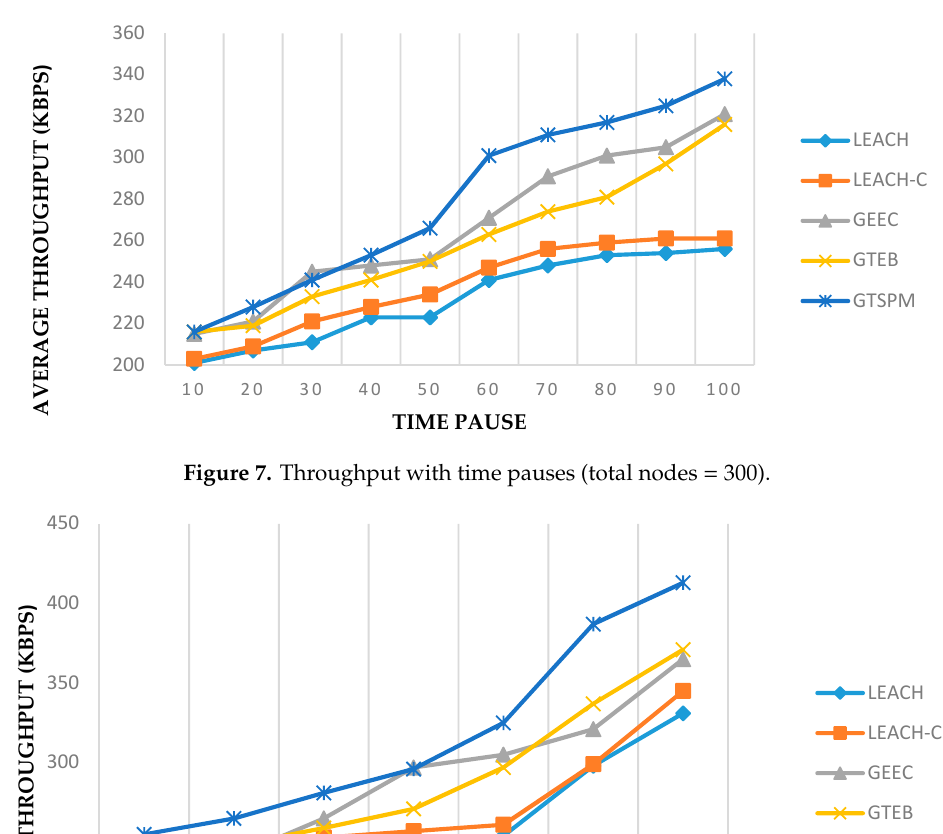
Figure 6. Average energy consumed with varying network size (pause time = 50).